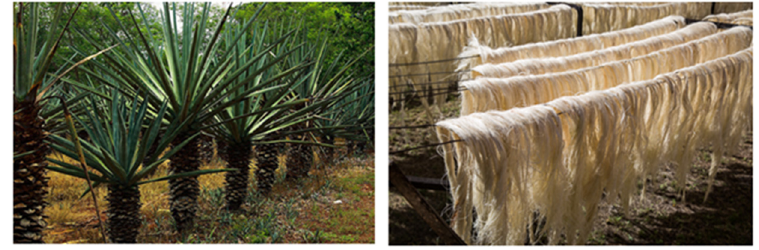
Figure 1. Photos of henequen plant and the extracted henequen fiber.